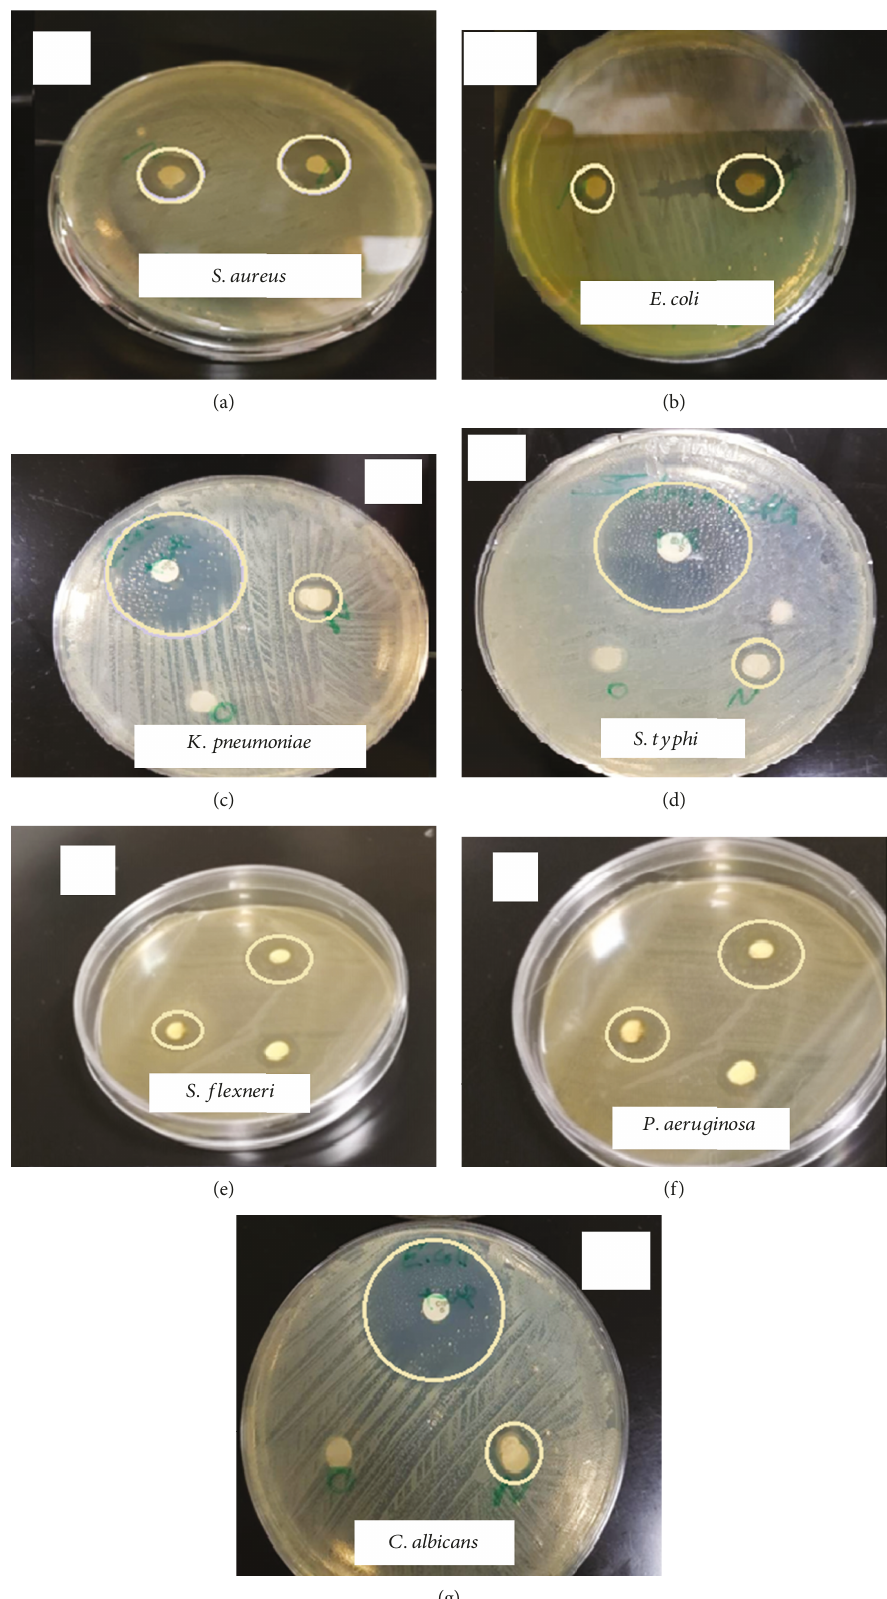
Figure 7: Screeningofthe Moringa oleifera oil/PVC-AgNPbionanocompositefor antibacterial andantifungalactivities bydiscdi ff usion